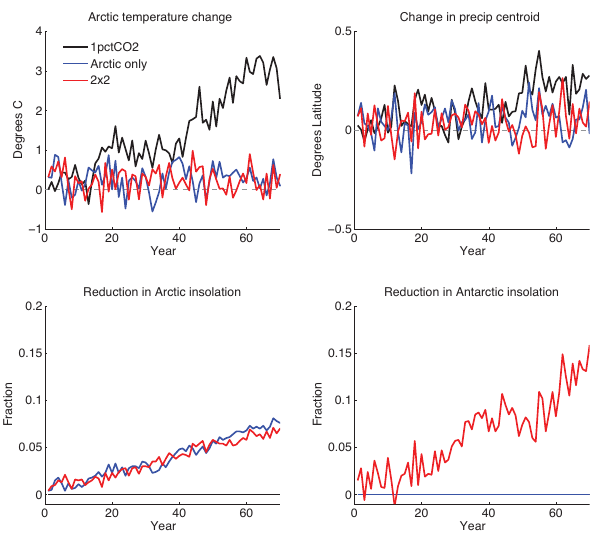
Figure 15. Same as Fig. 12 but for GISS ModelE2 (the evaluation